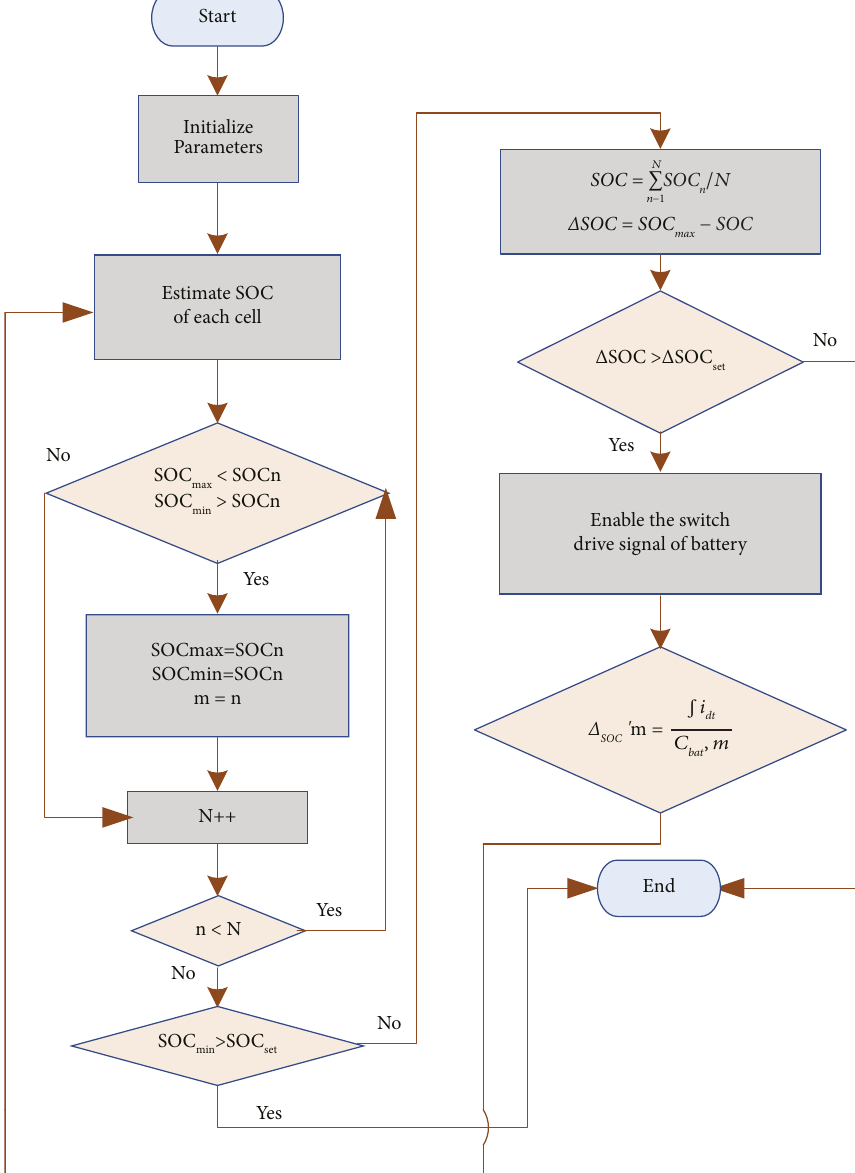
Figure 14: SOC estimation fow